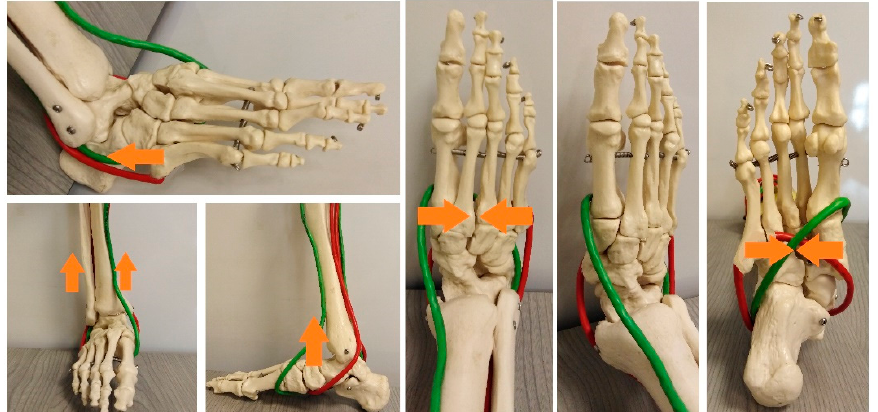
Figure 5. Model of the tendon stirrup (green) (muscle system I) and complementary muscles (red) (muscle system II) in various projections. The two muscle systems, due to their work in pairs, first produce pulling forces that constrict the posterior transverse arch and then support and lift the longitudinal arch. Arrows show the direction of the pulling muscle.